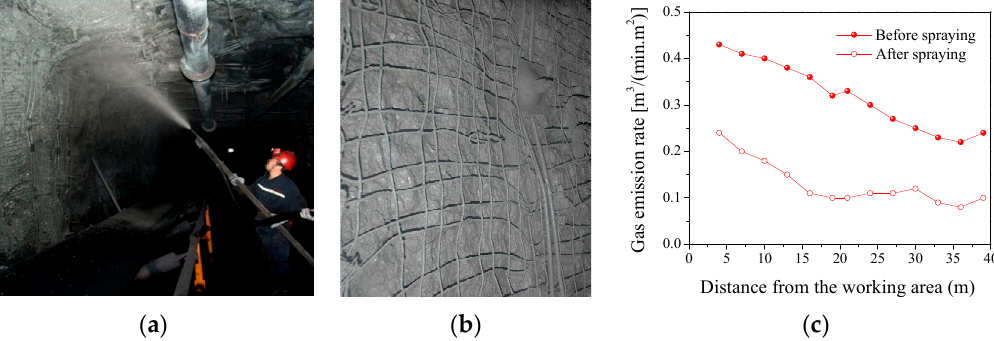
Figure 8. Pilot spraying tests on the underground tunnel wall. ( a ) Spraying process picture; ( b ) coal wall after spraying coating; ( c ) gas emission rate before and after spraying.